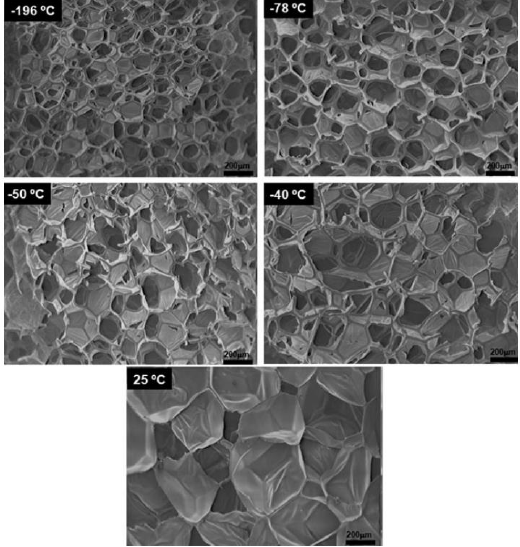
Figure 5. SEM images showing pore formation for PLLA scaffold during solvent extraction at different temperatures. Reproduced from [120].